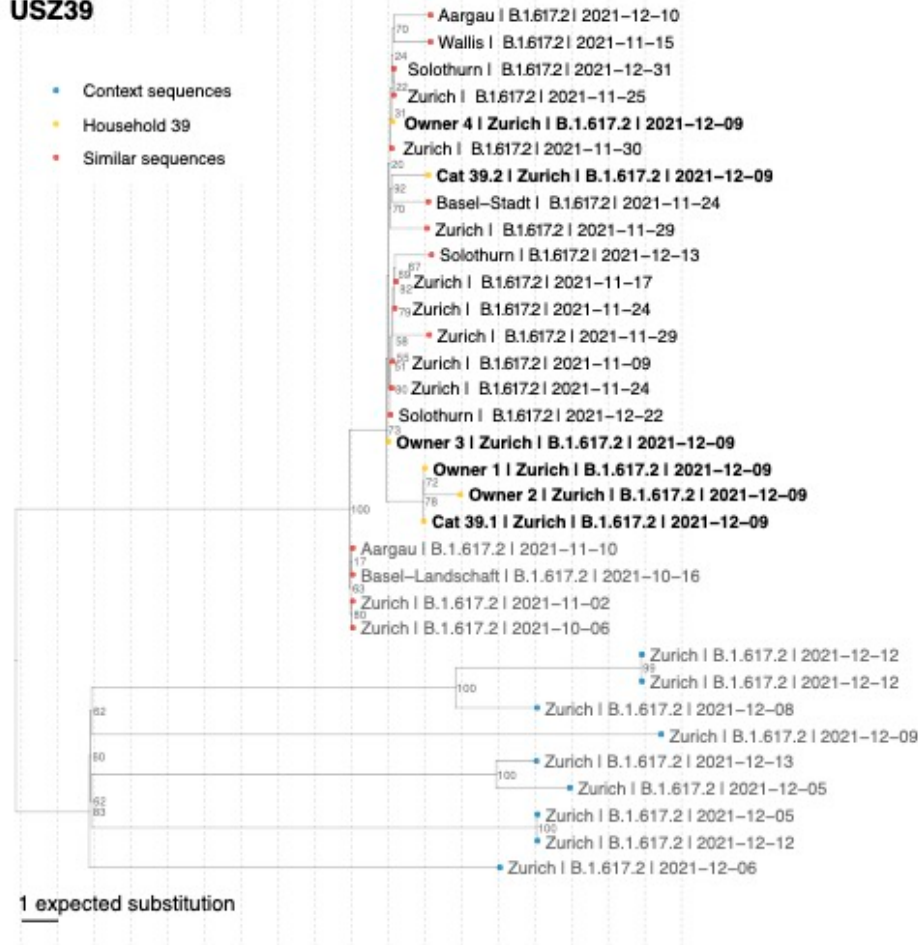
Figure A6. Maximum-likelihood phylogenetic tree showing the relationship between the five se- quences of USZ39 (yellow dots and bold text) and their respective 10 most genetically similar Swiss sequences from GISAID. The most similar sequences (red dots) are defined as those with the smaller number of SNPs differences to each household sequence (sequences that are part of the 10 closest sequences for several of the household sequences only appear once in the tree). Blue dots indicate a representative set of 10 sequences circulating in Zurich in November–December 2021 from pangolin lineage AY.43 (context sequences). Location, pangolin lineage, and collection date are shown for each sequence. Bootstrap values for the internal nodes are shown next to each node from 10,000 bootstrap replicates. Table A1. Rare and very rare, shared SNPs between companion animal sequences of this study and other companion animal sequences in GISAID. The percentage in which the SNP is found in all human, animal, and companion animal sequences in GISAID is calculated together with its 95% binomial proportion confidence interval using the Wilson method. Very rare mutations for the lin- eages in the study samples are indicated in bold.